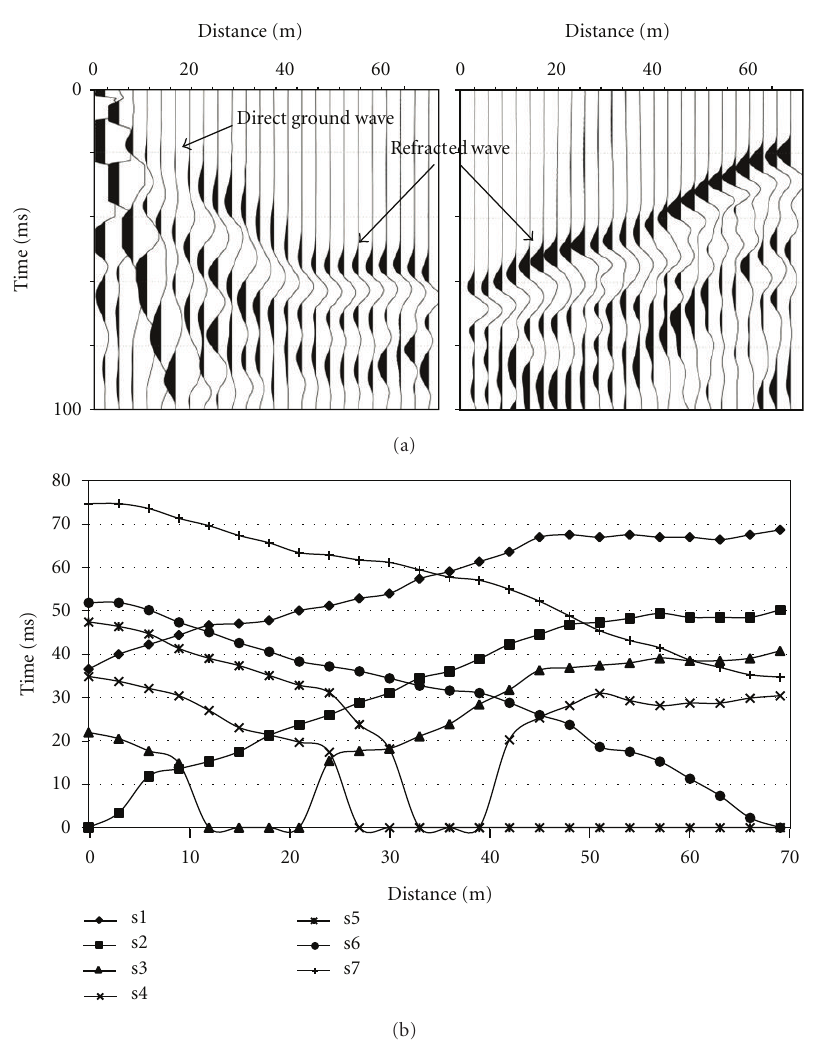
Figure 6: (a) Shots, s1 and s6, of seismic refraction line 8. (b) First arrivals of line